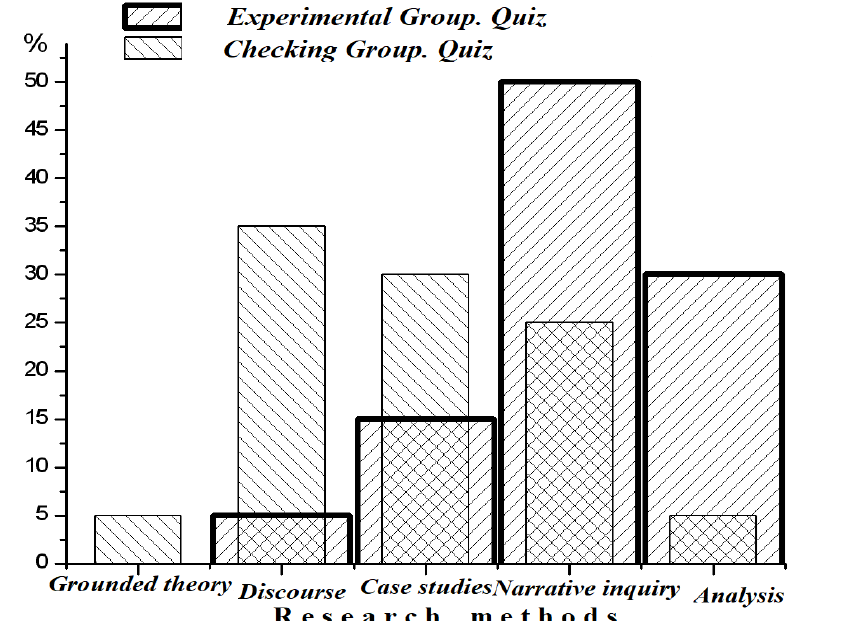
Fig. 1. — Instructional Conversations percentage ratio in elementary and pre-intermediate foreign language